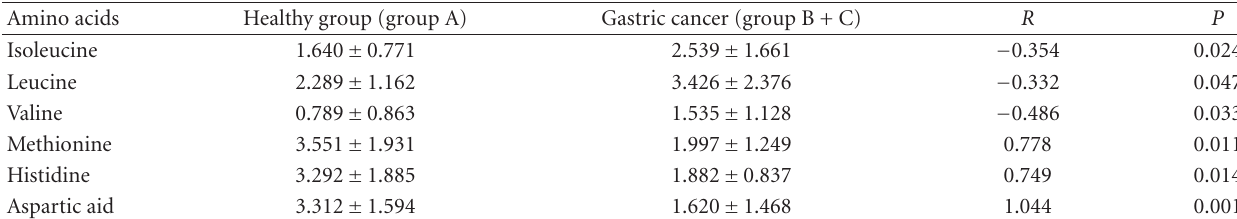
Table 1: Urine amino acid profiles of healthy adult group and gastric cancer group [ R = (healthy adult group − gastric cancer group)/gastric cancer